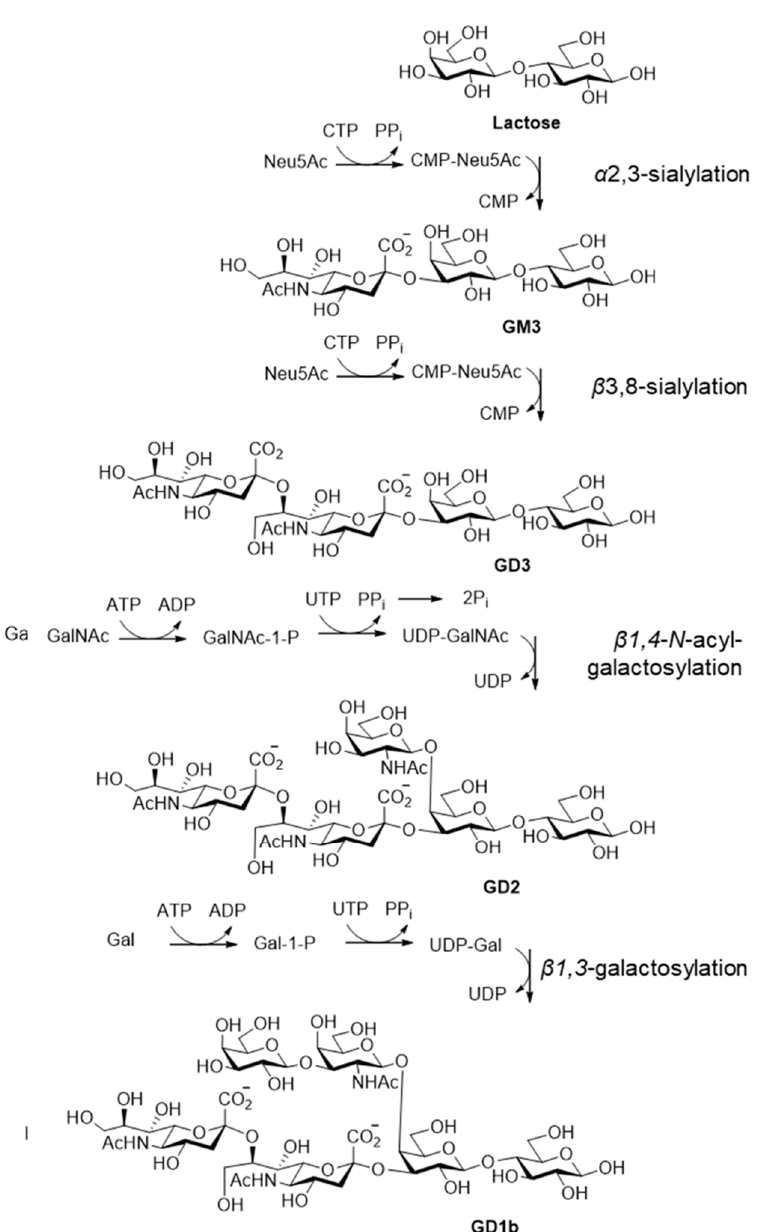
Figure 12. The enzymatic synthesis of GD1b glycan using OPME α 2,3-sialylation, α 3,8-sialylation, β 1,4- N -acyl-galactosylation, and β 1,3-galactosylation with a sacrificial (re)generation system for N -acetylneuraminic acid (Neu5Ac), N -acetylgalactosamine (GalNAc), and D -galactose (Gal).